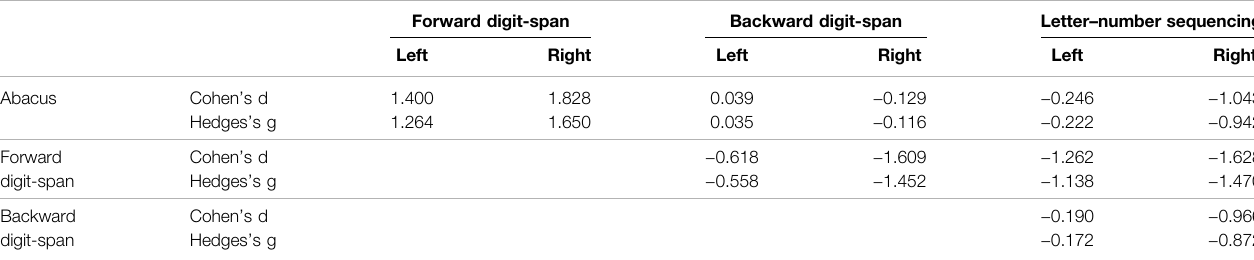
TABLE 3 | Cohen ’ s d and Hedges ’ s g for each